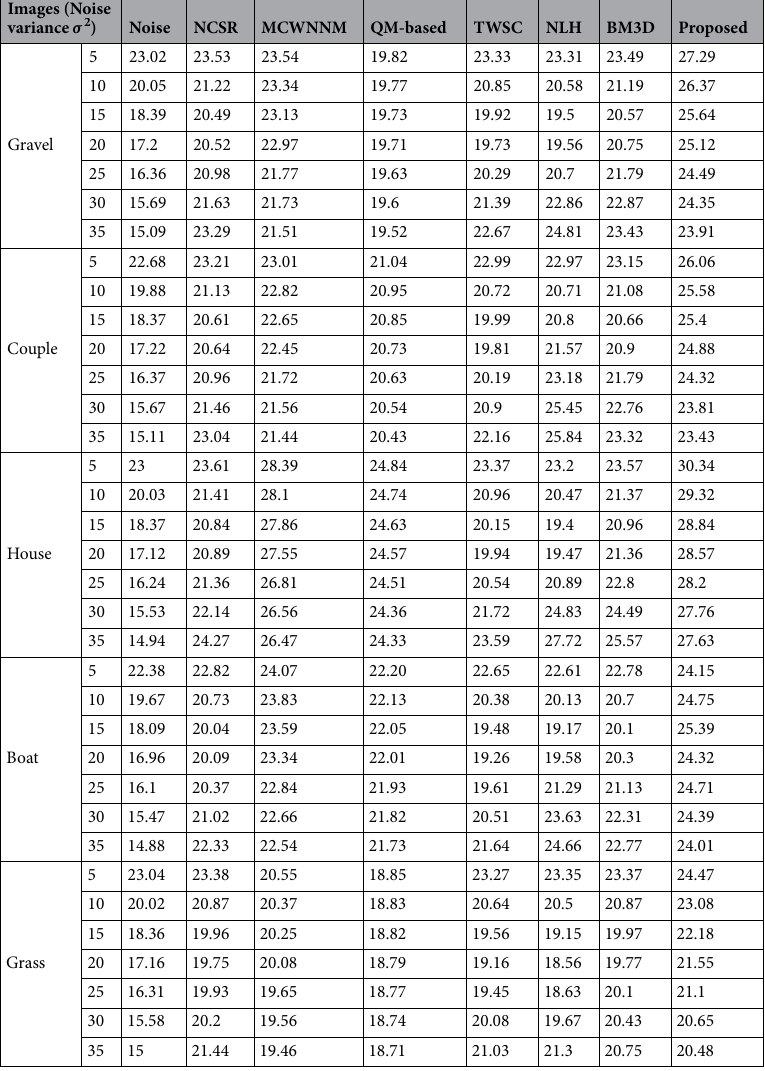
Table 6. Denoising results of various